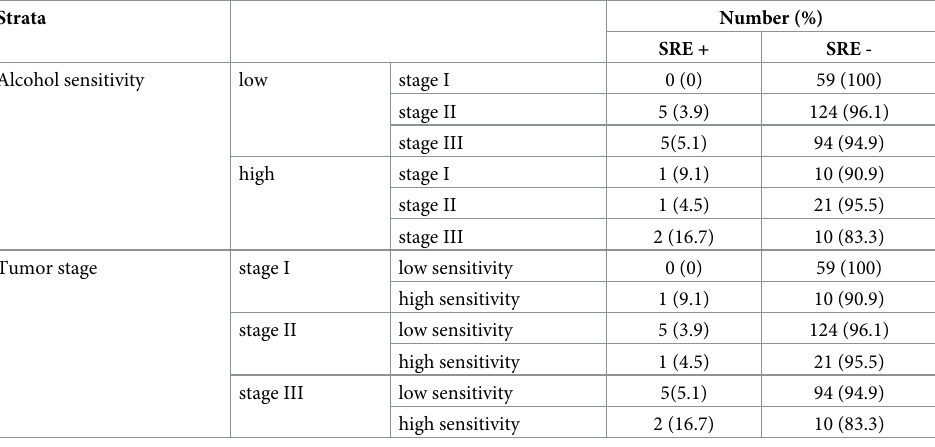
SREs, skeletal-related events.